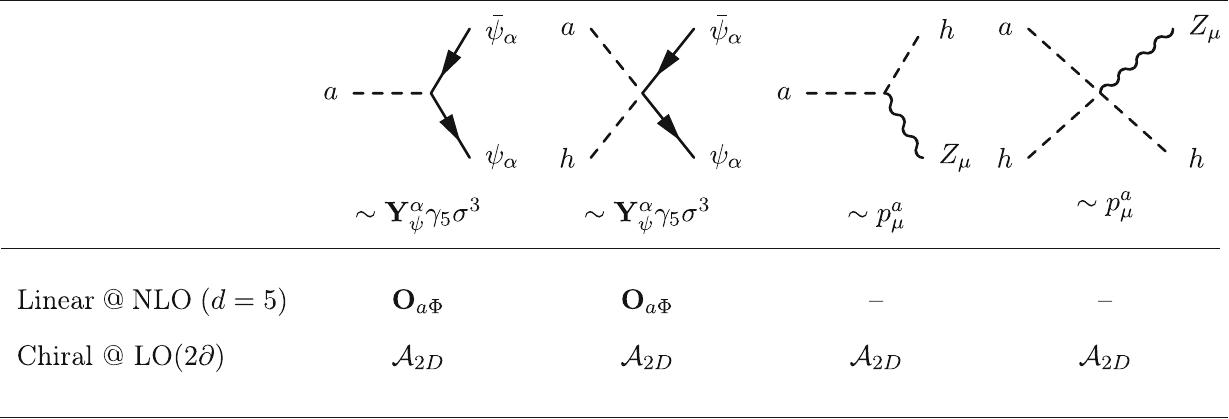
Table 1 Couplings resulting from the bosonic axion NLO linear cou- pling O a (cid:3) and from its LO chiral sibling A 2 D , as formulated in the Lagrangians Eqs. (16) and (55), respectively. Only fermionic vertices survive as physical impact from O a (cid:3) , as in the linear expansion